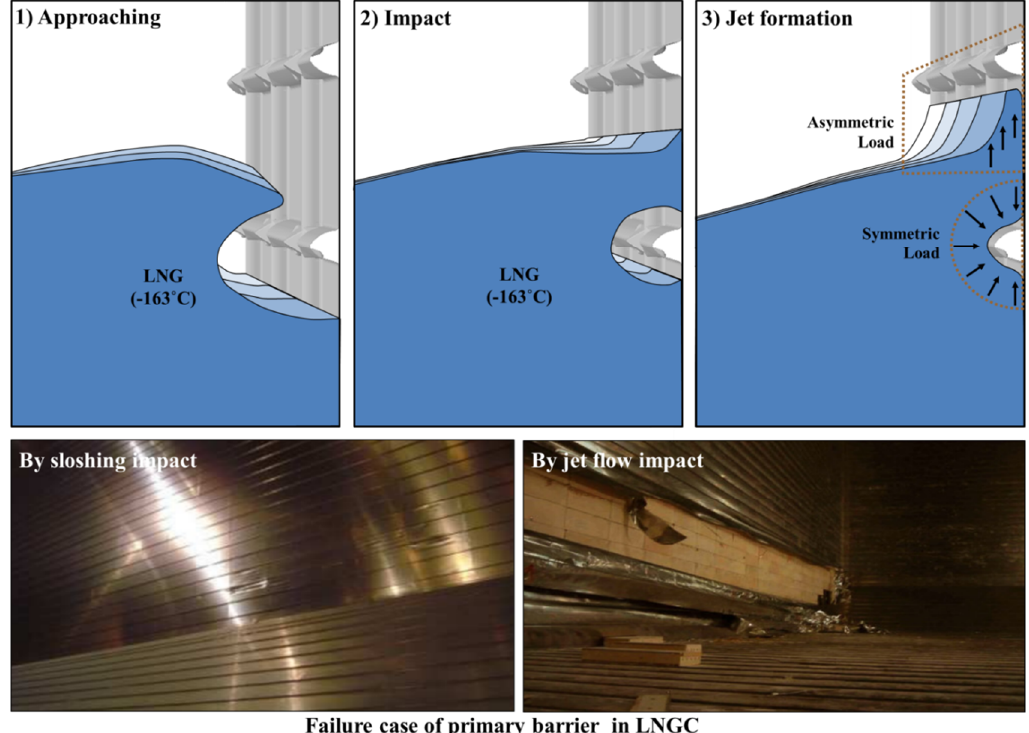
Figure 1. Schematic of sloshing impact applied to primary barrier in liquefied natural gas cargo containment system (LNG CCS).